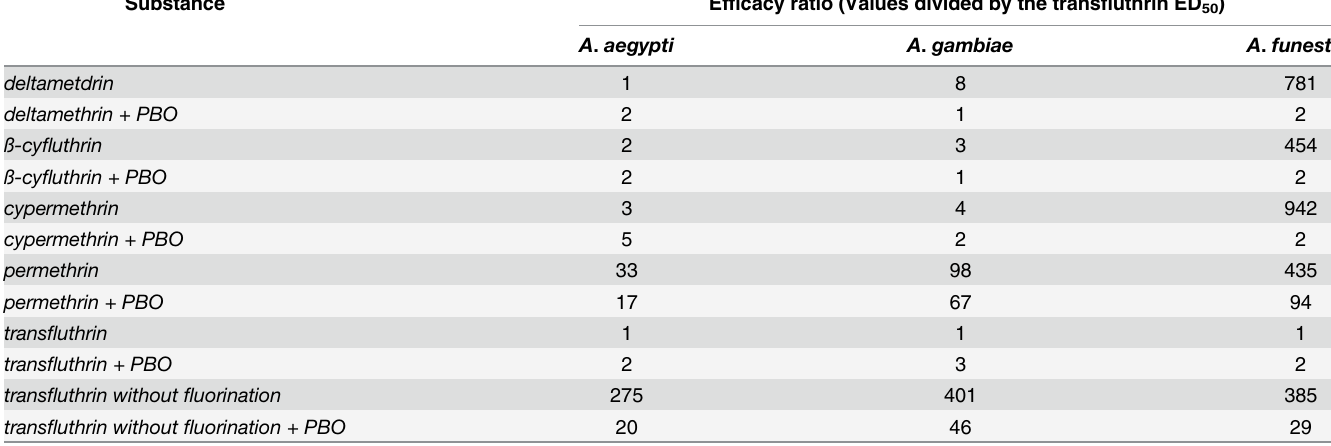
Table 3: Calculated ef fi cacy ratios for each tested mosquito strain. Trans fl uthrin ED 50 value was used as divisor of ED 50 of the respective